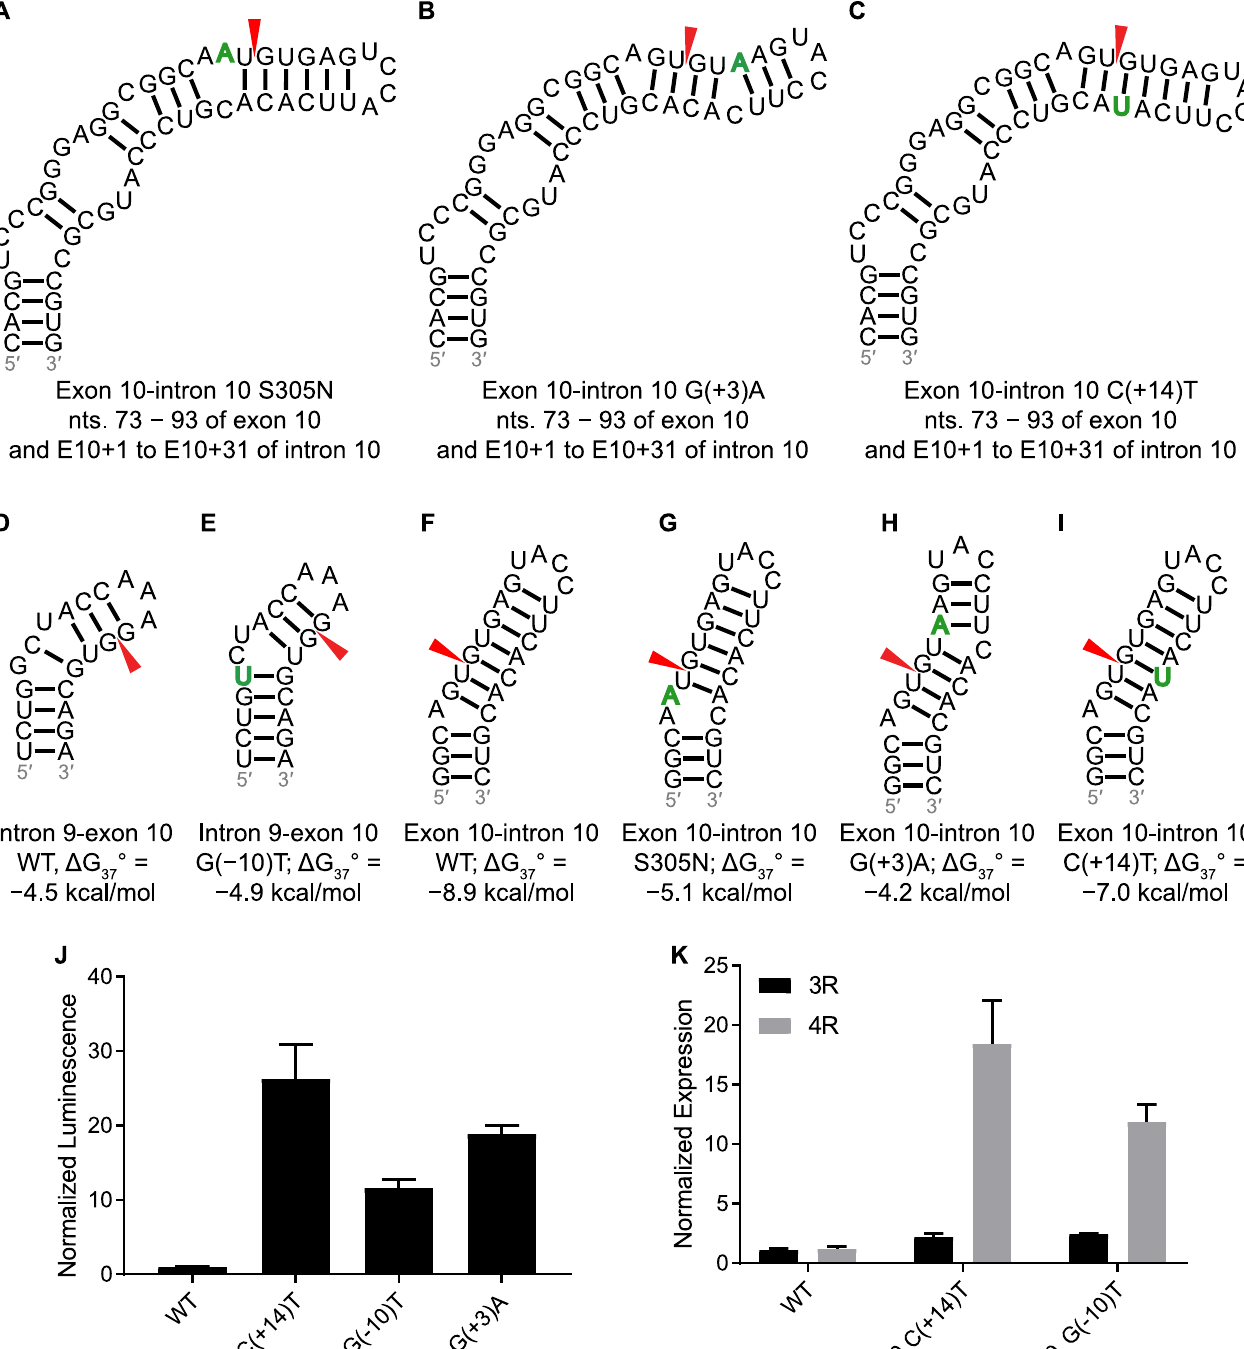
PLOS ONE | https://doi.org/10.1371/journal.pone.0219210 July 10,